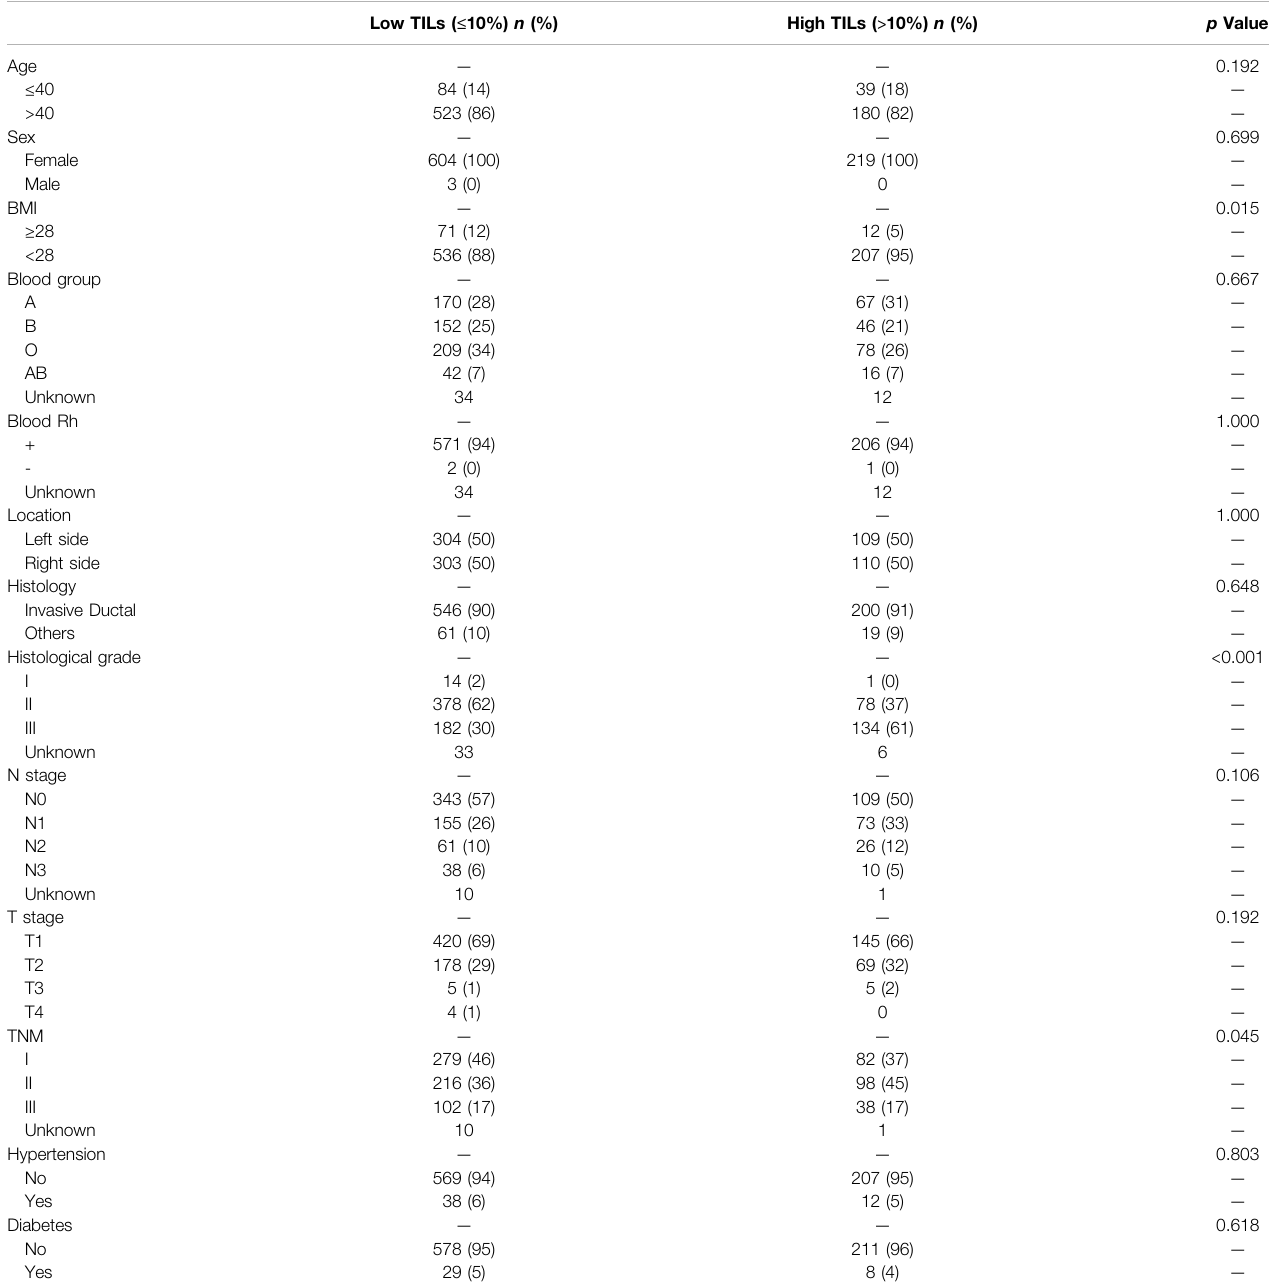
TABLE 1 | Patient and general